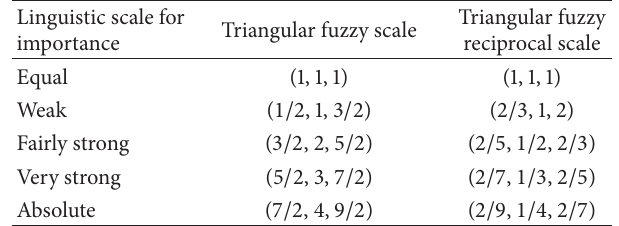
Table 1: Criteria and subcriteria considered to evaluate EI. Criteria